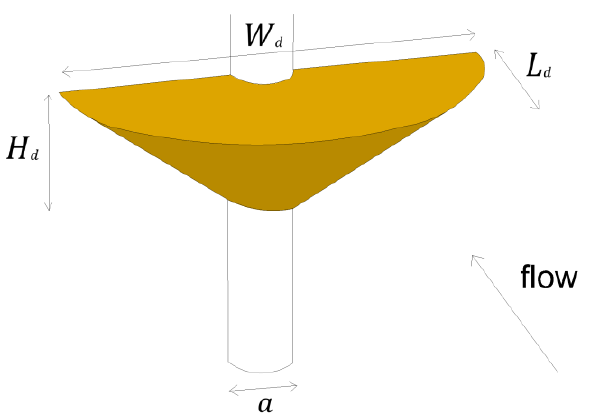
Figure 6. Idealized sketch of a debris accumulation at the bridge pier according to Panici and Almeida’s model [48]. Figure adapted from the same source [48].